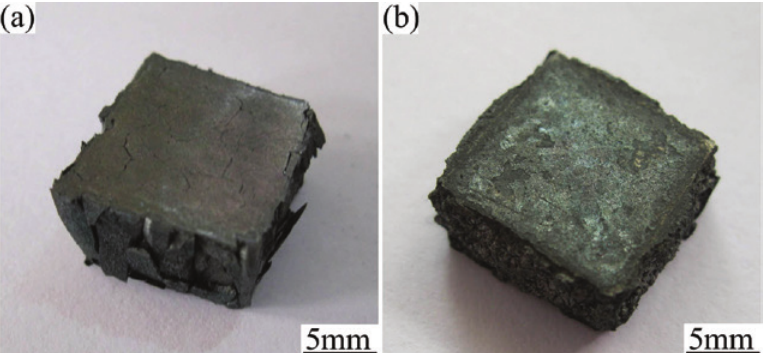
Fig. 13: Macro-morphology of the compressed specimen: (a) the columnar grain; (b) the equiaxed grain